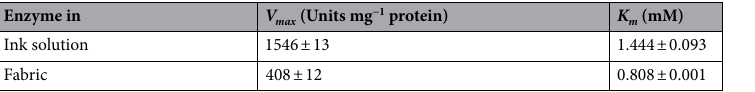
Table 4. Kinetic parameters of tyrosinase in free-form (ink) and after printing-rinsing process (fabric).